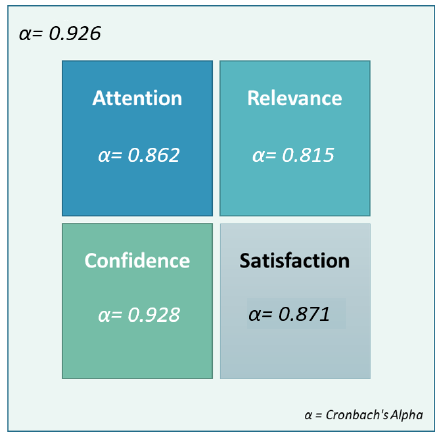
Figure 7. Reliability measure for Instructional Materials Motivation Survey